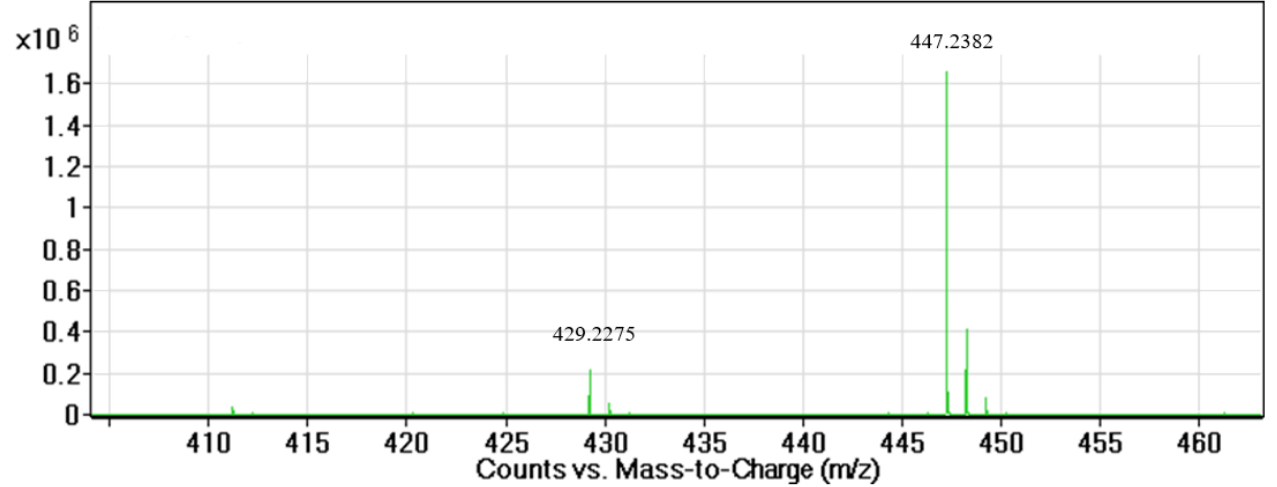
Figure 1. Mass spectra of the purified compound using QTOF LC–MS with ESI+ scan mode.